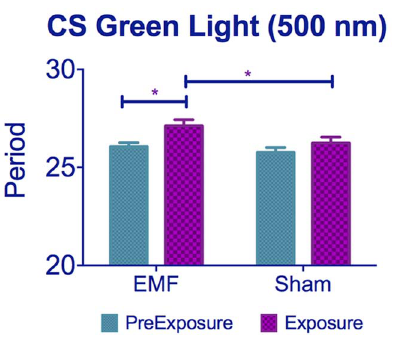
Figure 8. Exposure to 500 nm green light lengthens circadian period under EMF. CS flies kept under 500 nm show period lengthening when exposed to EMF compared to sham flies. See Table S1, post-hoc *p , 0.05, ***p , 0.001). Mean 6